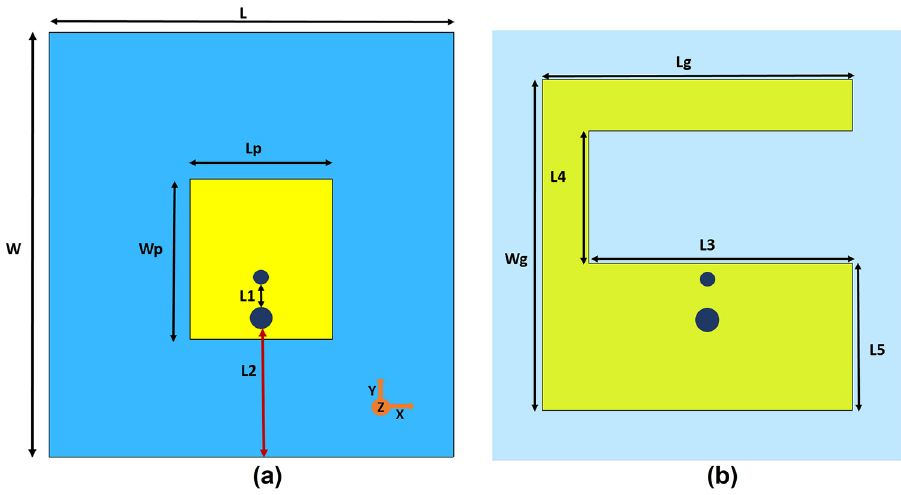
Figure 2. Initial antenna design, ( a ) top view-rectangular patch ( b ) ground plane with rectangular slot; blue area defines